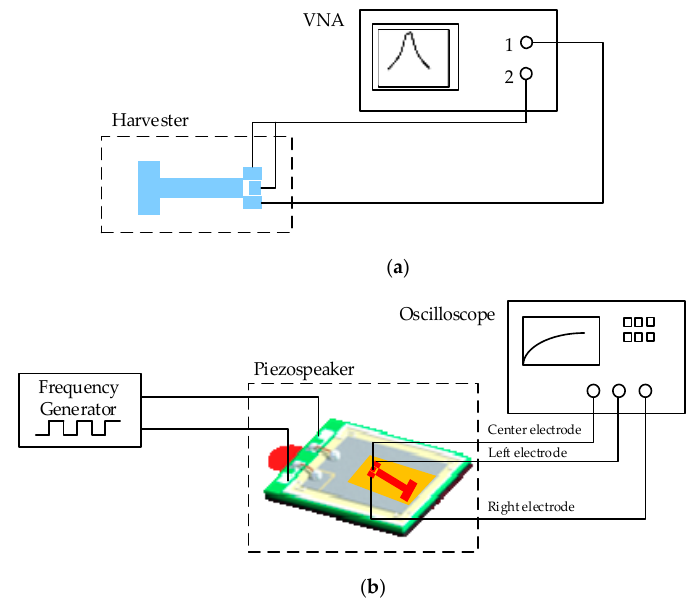
Figure 12. ( a ) Resonance test setup and ( b ) output power test setup.